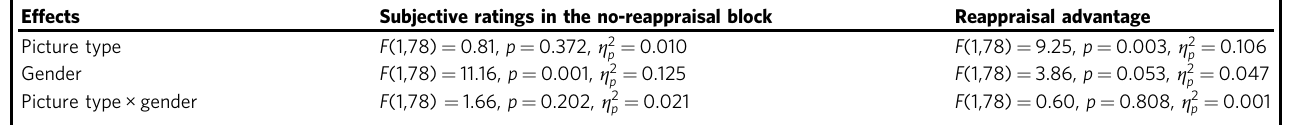
Table 4 Results of the ANOVAs for gender effects.